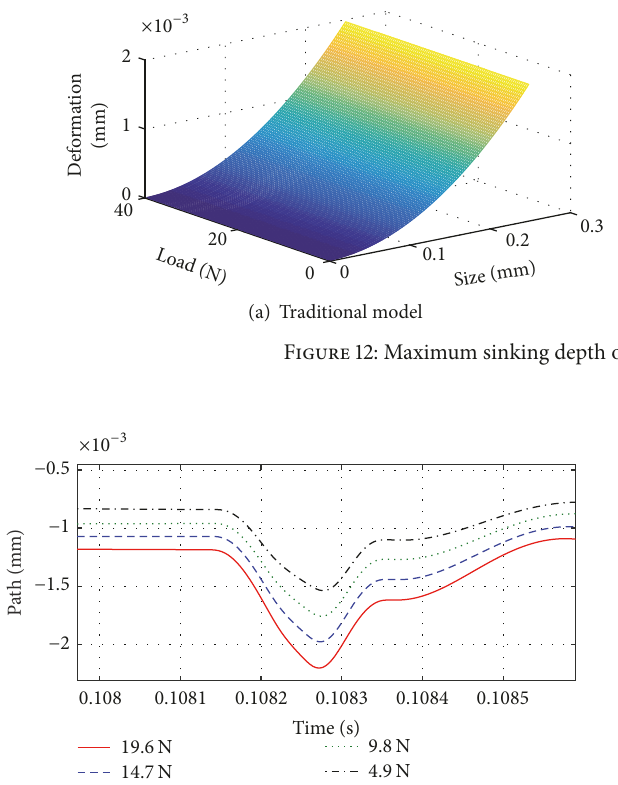
Figure 13: Paths of the balls passing through the defect area under different